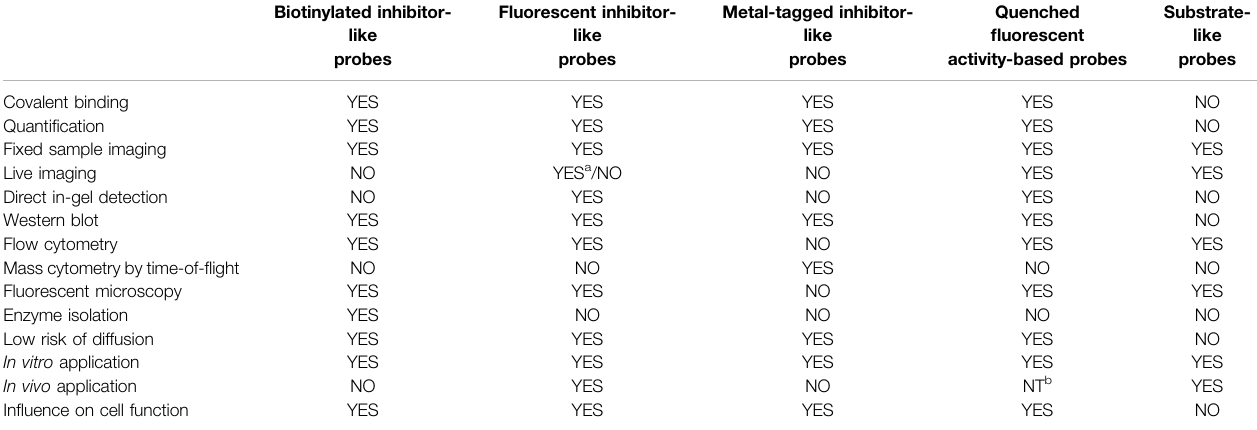
TABLE 1 | Strengths and weaknesses of different types of serine protease probes described within the